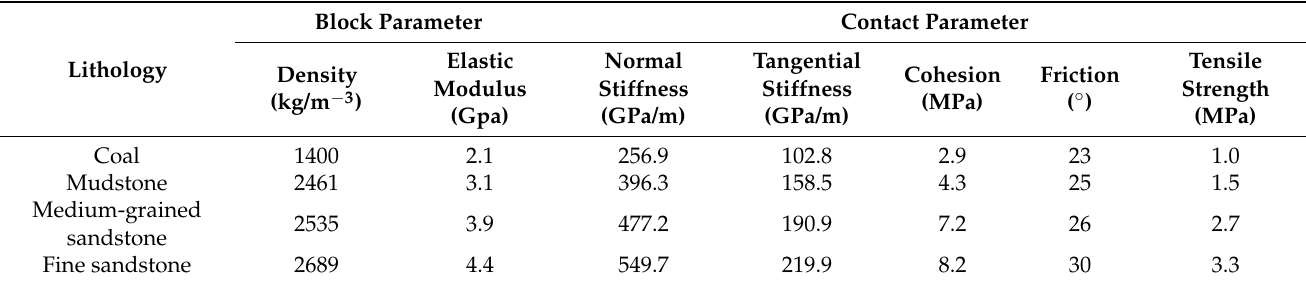
Table 1. Short-term parameters of other strata.